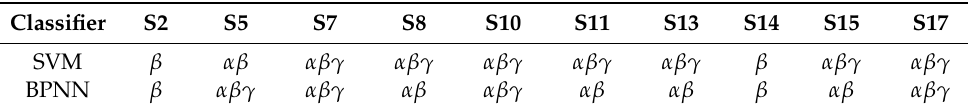
Table 6. Energy band range yielding highest accuracy for some subjects using both classifiers. To save space, α + β + γ is denoted as αβγ .